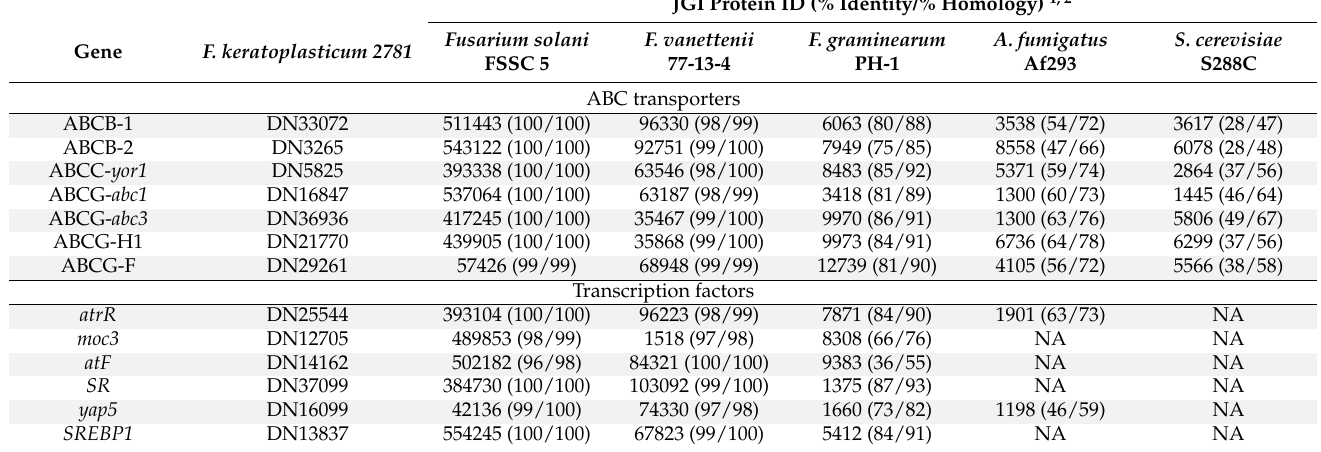
Table 1. Fungal orthologs or closest homologs of proteins encoded by F. keratoplasticum DEGs. Results of BLASTp searches with F. keratoplasticum gene products as queries against protein sequences of F. solani FSSC5, F. vanettenii 77-13-4, F. graminearum PH-1, A. fumigatus Af293 and S. cerevisiae S288C obtained from the Joint Genome Institute (JGI) MycoCosm